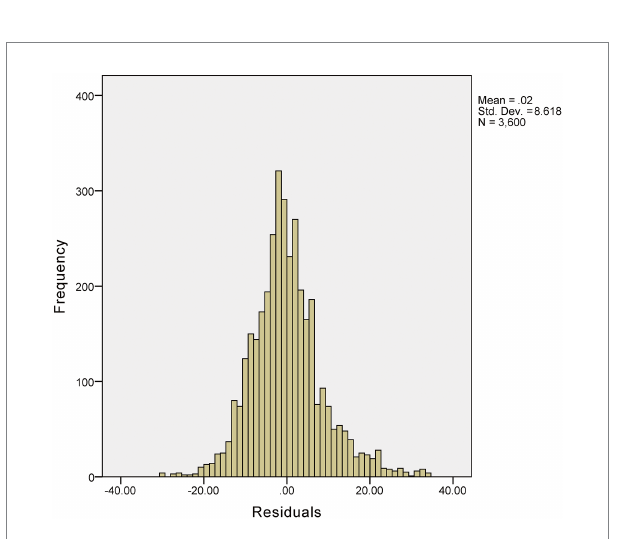
FIGURE 3 Deming regression-predicted residual values distribution.